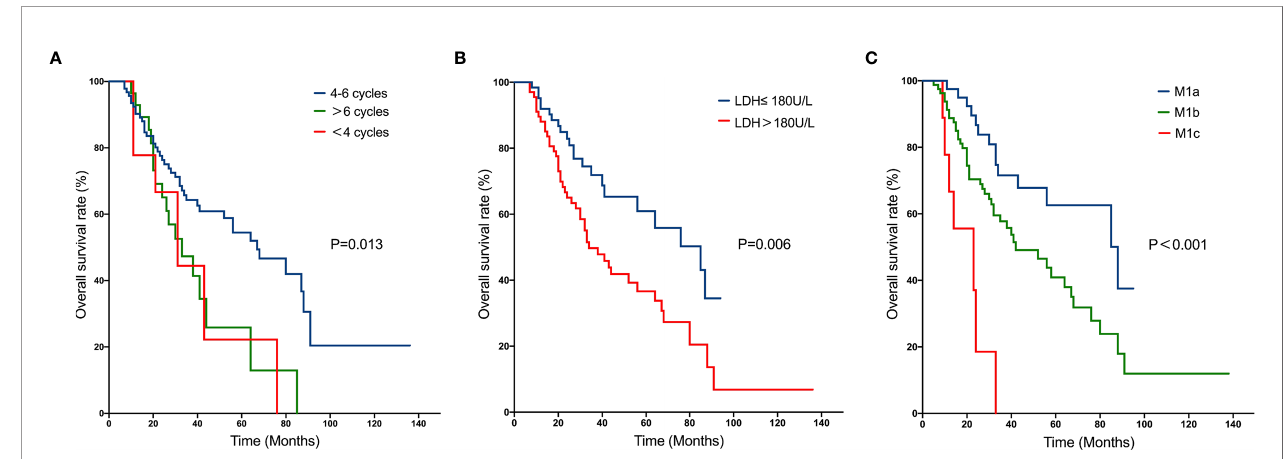
FIGURE 1 | Kaplan – Meier curves of overall survival rates in patients with metastatic nasopharyngeal carcinoma: number of cycles of chemotherapy (A) ; pre-treatment serum LDH level (B) ; M1 stage subdivision (C)